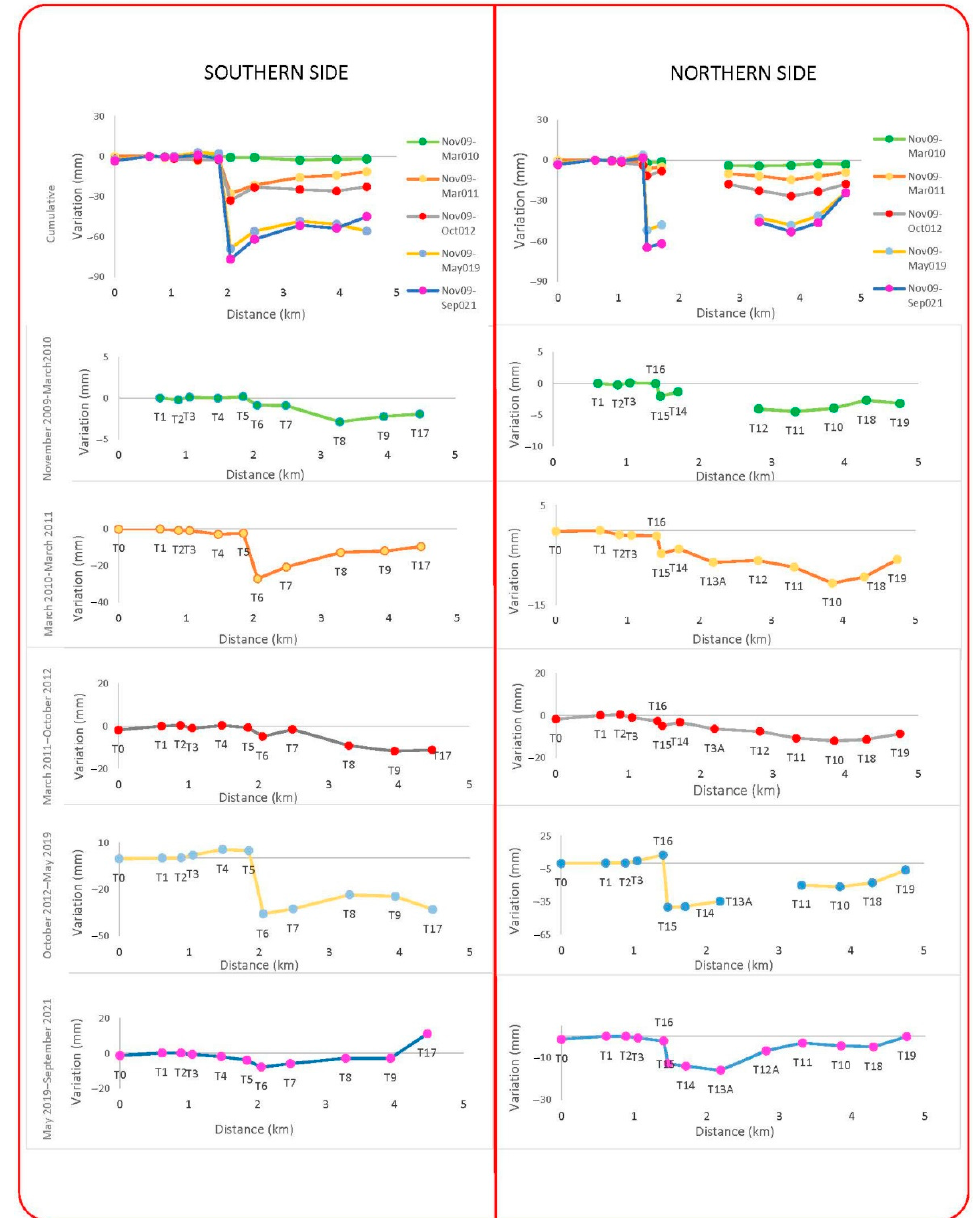
Figure 10. Vertical displacements measured by the levelling surveys on the southern and northern sides of the network. In the first row, the cumulative effects of the dislocation are plotted for each side by comparing each survey with the first one of 2009. In the following rows, each survey is compared with the previous one to show each subsequent period independently for evidencing the changes of behaviour of the fault in time for each side of the levelling route across the fault.